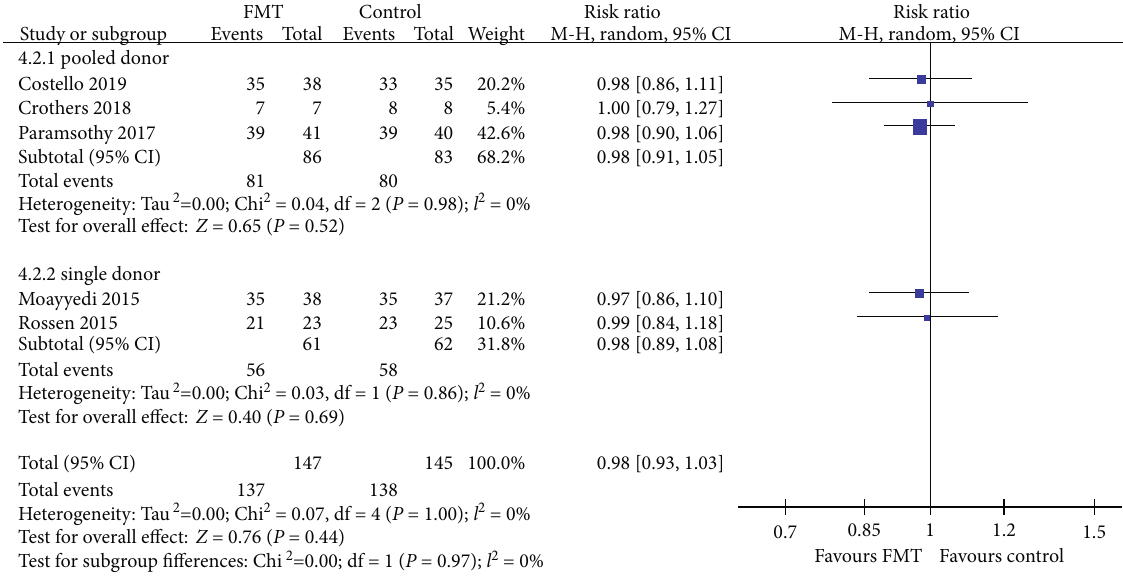
Figure 13: Forest plot of studies reporting serious adverse events and subgroup analysis according to number of donors.